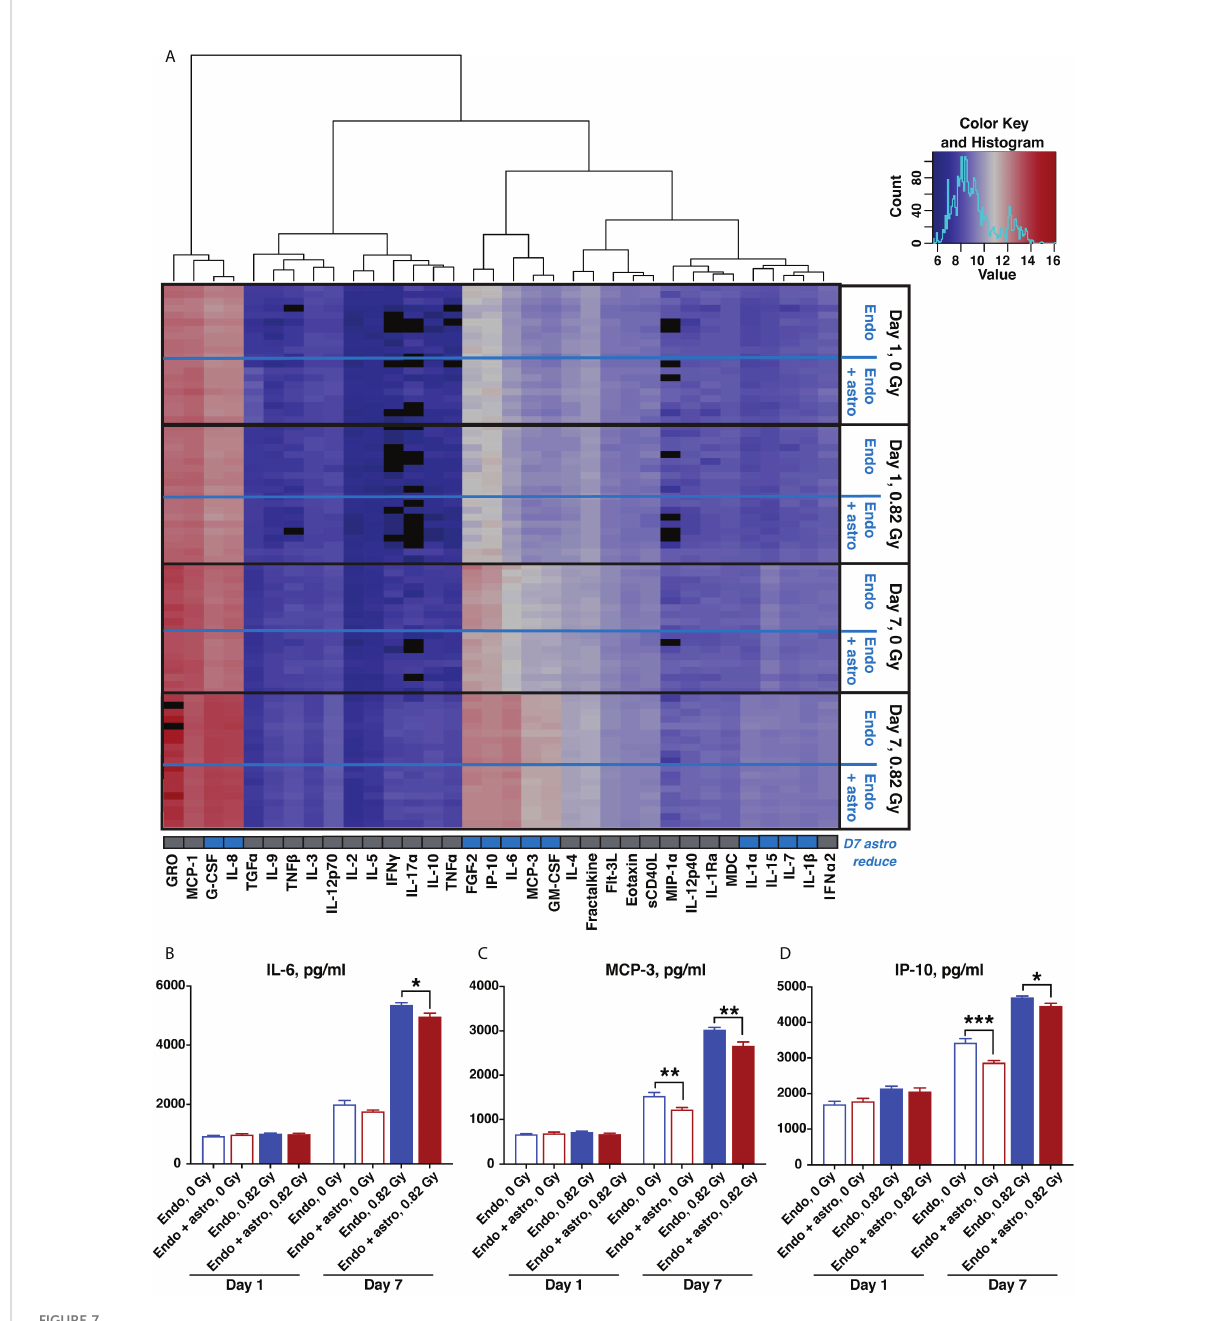
FIGURE 7 600 MeV/n 56 Fe radiation stimulates in fl ammatory cytokine and chemokine production, which is partially mitigated by astrocytes in the subacute phase after irradiation. (A) Heatmap of supernatant cytokine and chemokine quanti fi cation, pg/ml, log 2 scale, blue (low) to red (high). Black, no data available. Bottom row, cytokines that are signi fi cantly reduced by astrocyte presence 7 days after irradiation (p < 0.05, 2-way ANOVA) marked in blue. (B – D) Representative quanti fi cation of key in fl ammatory cytokines and chemokines: IL-6 (B) , MCP-3 (C) and IP-10 (D) , 1 and 7 days after irradiation with 600 MeV/n 56 Fe particles. Open bars, cytokines and chemokines secreted by endothelial cells only. Shaded bars, cytokines and chemokines secrered by endothelial cells together with astrocytes. Blue, 0 Gy sham irradiation. Dark red, higher dose (0.82 Gy). N = 9-10 chips per condition. Error bars, mean ± SEM. *p < 0.05, **p < 0.01, ***p < 0.001, Student ’ s t-test. Non statistically signi fi cant changes are not